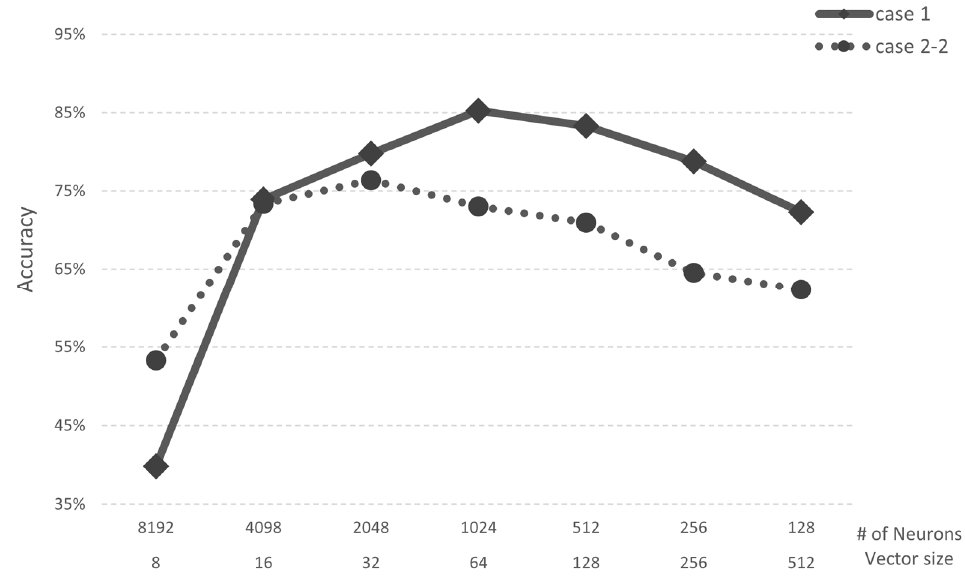
Figure 9. Accuracy of Case 1 and Case 2-2.